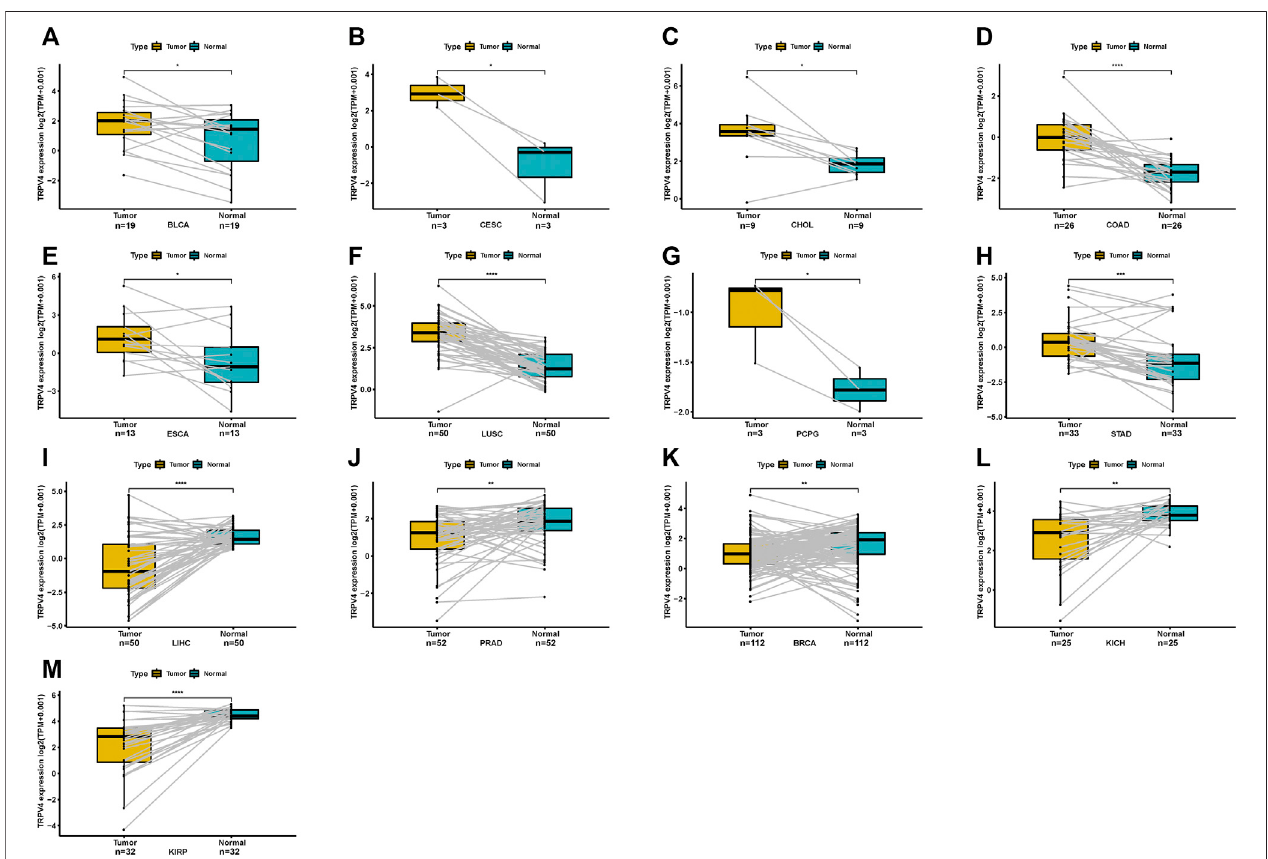
FIGURE 2 | Pan-cancer TRPV4 expression in paired tumor and adjacent normal tissues. (A – M) Pan-cancer TRPV4 expression in paired tumor and adjacent normal tissues in indicated tumor types from TCGA.